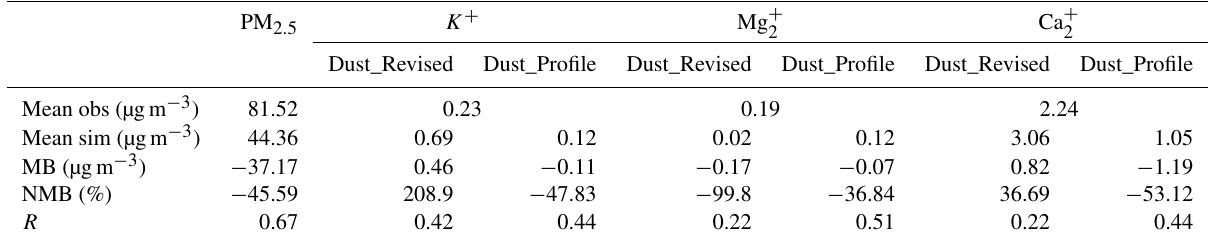
Table 6. Evaluation statistics for tracer metals and PM 2 . 5